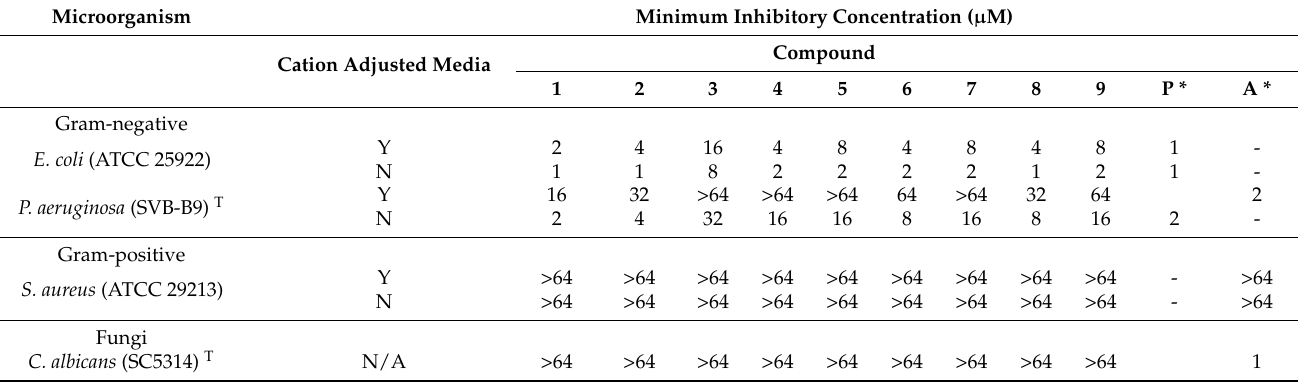
Table 1. Minimal inhibitory concentrations (MICs) for synthetics ( 1 ) and analogues ( 2 – 9 ). Microorganism Minimum Inhibitory Concentration ( µ M) Cation Adjusted Media